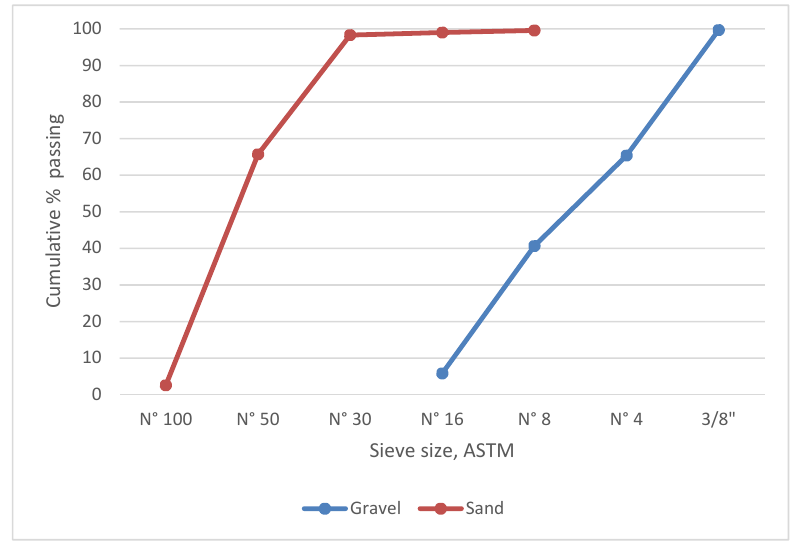
Figure 4. Granulometry of the sand and gravel used for gravel–sand–tailings mixtures.